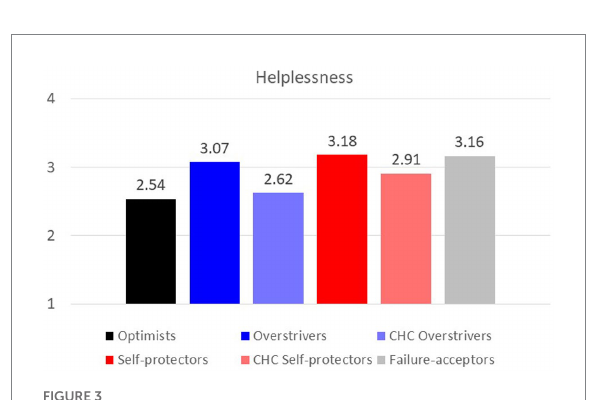
FIGURE 3 Levels of learned helplessness across categories.